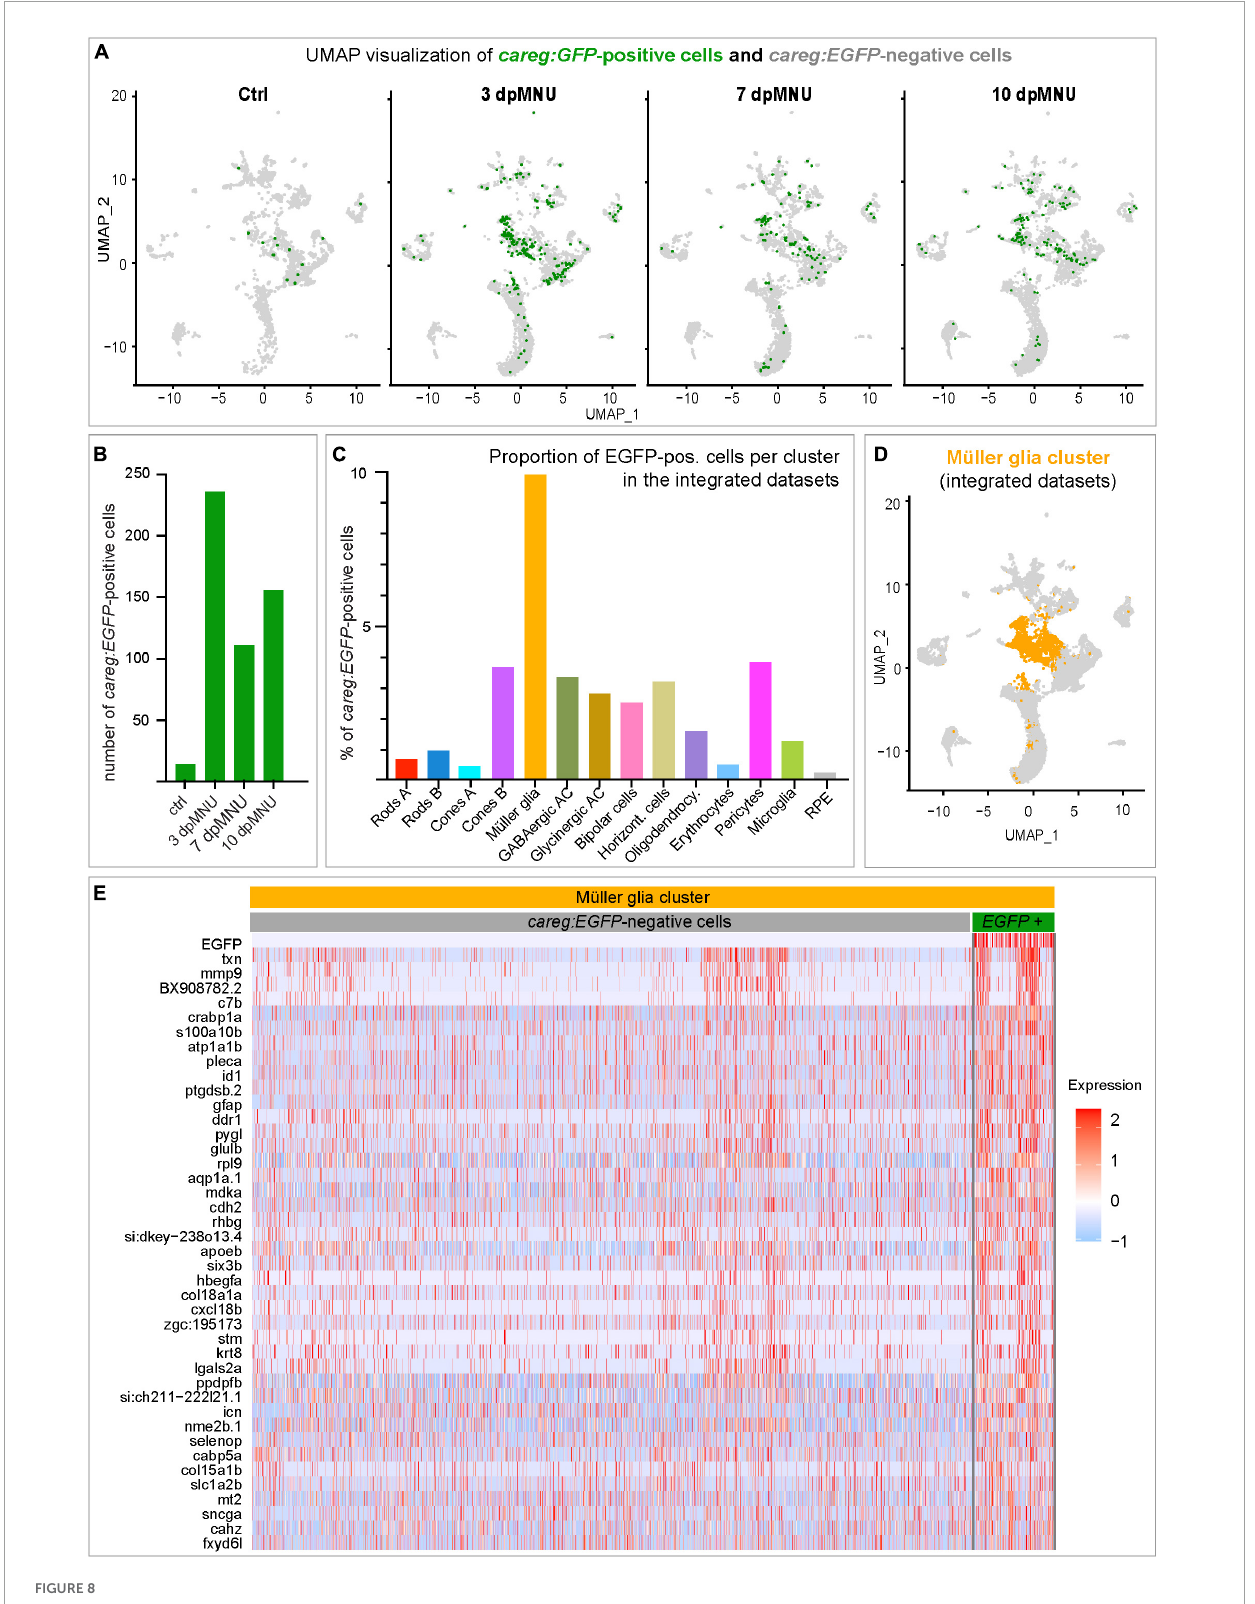
FIGURE8 careg:EGFP is expressed in a subpopulation of Müller glia after MNU injury. (A) UMAP plots showing the distribution of careg:EGFP -positive cells (green) per condition. (B) Bar plot showing numbers of careg:EGFP -positive cells per time-point. (C) Histogram displaying the proportion of careg:EGFP -positive cells per cluster in the integrated cell RNA-sequencing data. (D) UMAP plot showing the distribution of the Müller glia cluster cells (orange) in the integrated scRNA-seq data. (E) A heatmap of differential gene expression analysis in careg:EGFP -positive cells compared to EGFP -negative cells within the Müller glia cluster. Complete data are in Supplementary Table 10